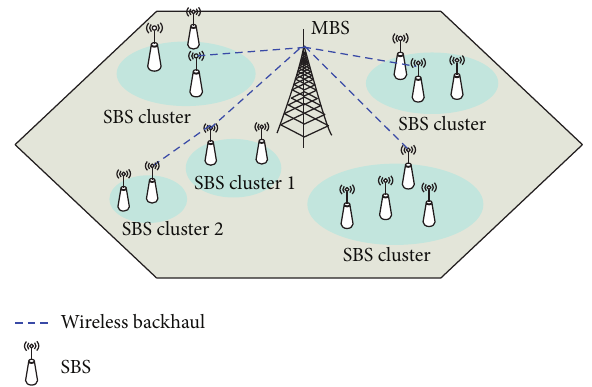
Figure 1: Illustration of a 5G-network with mm-Wave wireless backhaul.